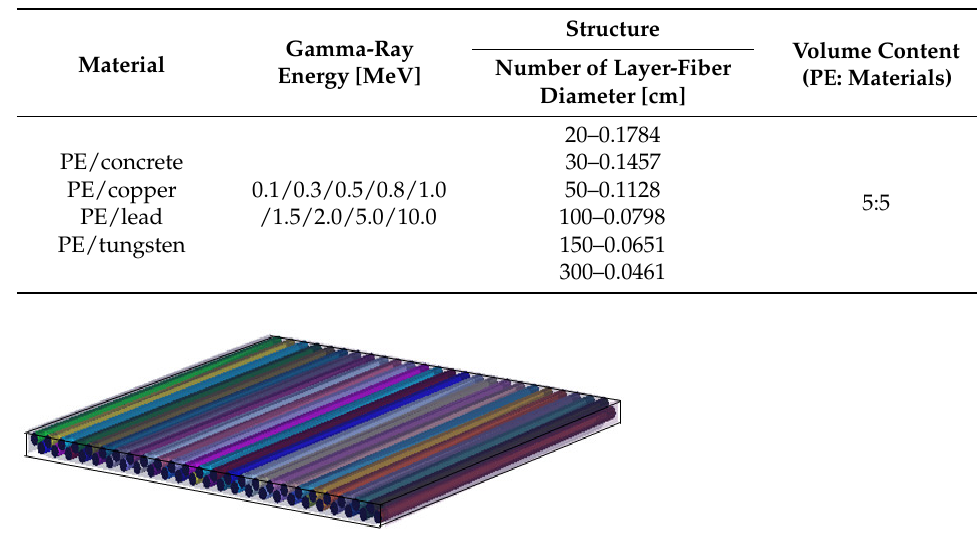
Table 2. Condition of simulation for fibrous composites.